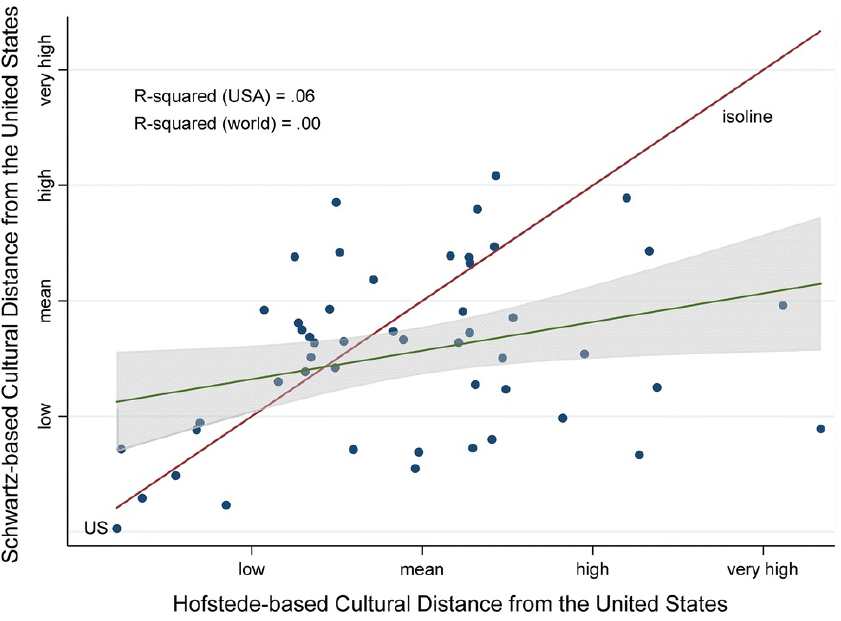
Fig. 8 Comparison of motion trajectories in a single direction between individual landmarks.